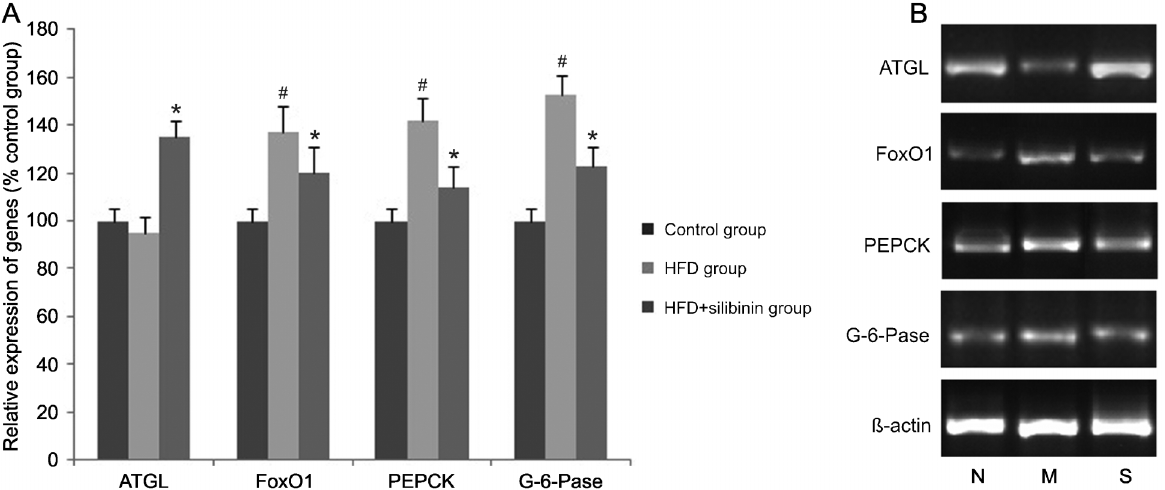
Figure 4. Relative expression of adipose triglyceride lipase (ATGL) in adipose tissue and hepatic gluconeogenesis-associated genes in each group. Expression of ATGL, the rate-limiting gene in lipolysis, was decreased in the high-fat diet (HFD) group, indicating inhibition of lipolysis induced by the high-fat diet. In contrast, increased expression of Forkhead box O1 (FoxO1), phosphoenolpyruvate carboxykinase (PEPCK) and glucose-6-phosphatase (G-6-Pase) was found in the HFD group, implying enhancement of gluconeogenesis. Silibinin enhanced the expression of ATGL, but decreased that of FoxO1, PEPCK and G-6-Pase. *P , 0.05 vs the HFD group; # P , 0.05 vs the control group (ANOVA followed by the Bonferroni multiple comparisons test). Panel B , RT-PCR: N = control group; M = HFD group; S = HFD + silibinin